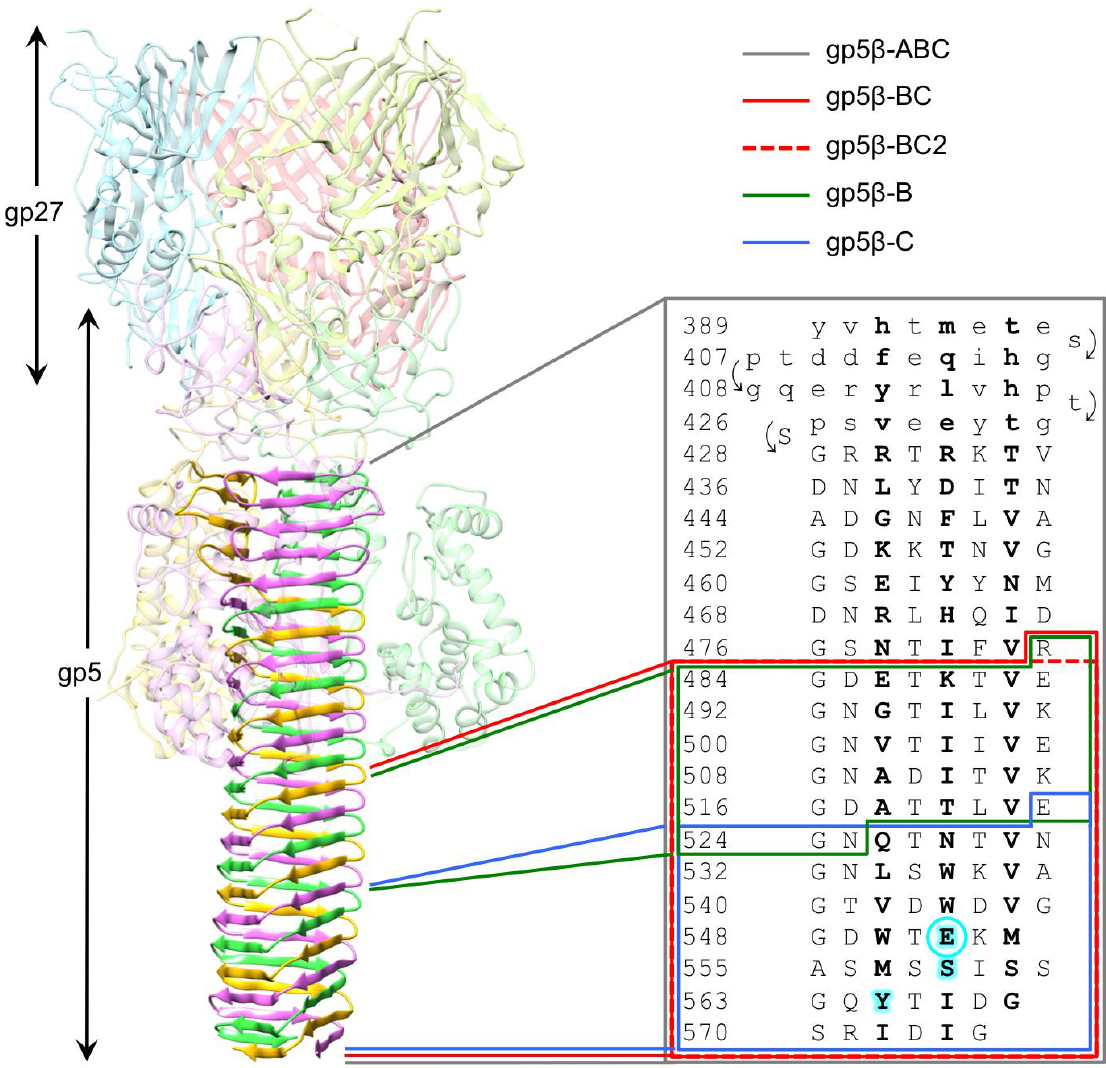
Figure 1. Design of gp5 β -helix fragments. Ribbon diagram of the gp5-gp27 complex shows the location of the gp5 β -helix within the complex. Residues comprising the N-terminal part of the β -helical domain with an antiparallel β -sheet topology are shown in small letters. The corkscrew part of the β -helix is in capital letters. Residues pointing inwards are highlighted in bold. Residues involved in binding of the buried metal ion and associated water molecules are highlighted with a cyan background with the critical glutamates (Glu552) emphasized with an additional circle.